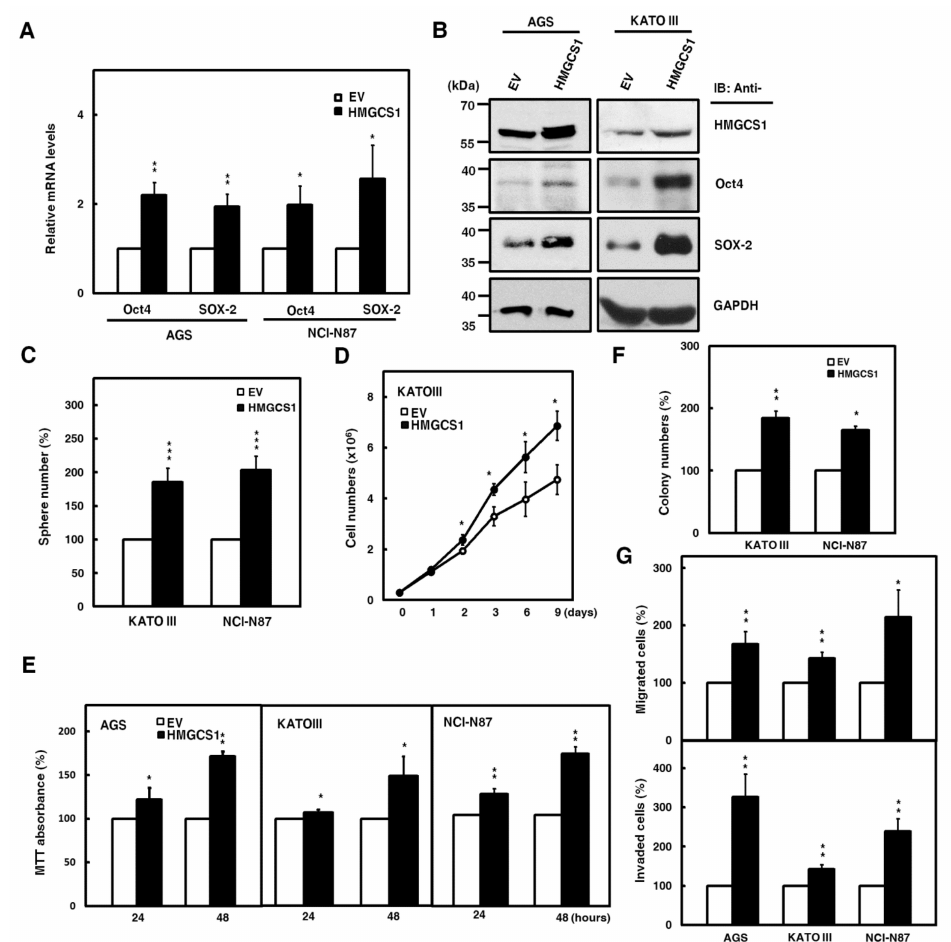
Figure 2. HMGCS1 elevates the levels of pluripotency genes Oct4 and SOX-2 and contributes to progression in gastric cancer cells. ( A,B ) AGS, NCI-N87, and KATO III cells were transfected with the HMGCS1-expressing plasmid construct (HMGCS1) or empty vector (EV) for 48 h. The transcript levels of Oct4 and SOX-2 in the transfected AGS and NCI-N87 cells were determined by quantitative real-time PCR (A). Mean ± SD ( n = 3). Whole-cell extracts of the transfected AGS and KATO III